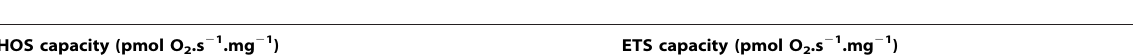
Table 4. Respiratory parameters from substrate-uncoupler-inhibitor titration protocol 2 (SUIT2) applied on equine permeabilized fibres of triceps brachii : OXPHOS and ETS capacities in trained horses ( N = 15; trained horses matched with SUIT1 and SUIT3 protocols).